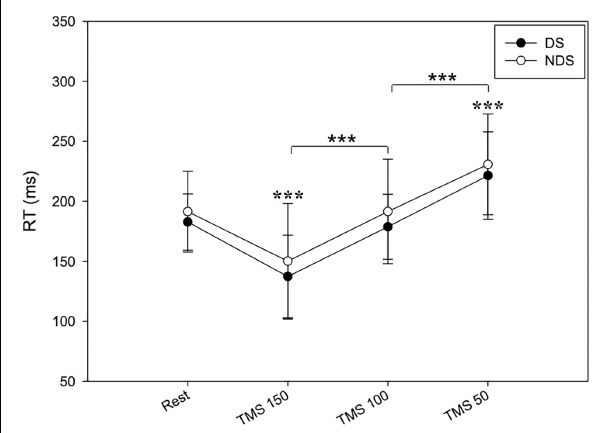
bas., baseline. Data expressed as mean ± st.dev.